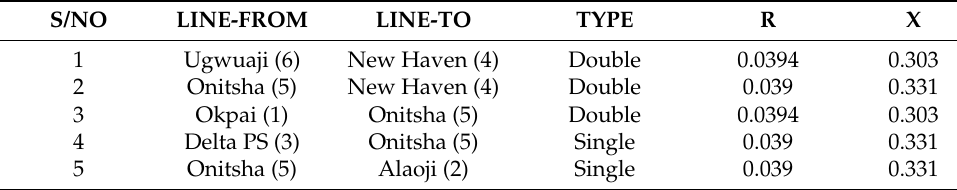
Table 1. Network data